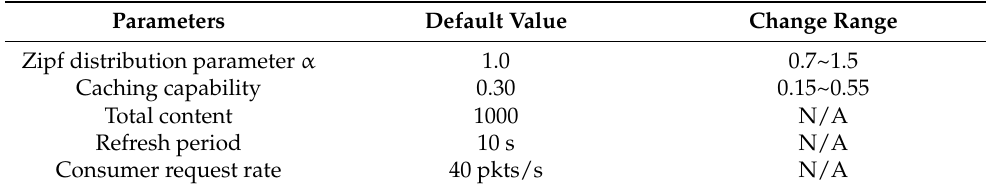
Table 1. Parameters of the